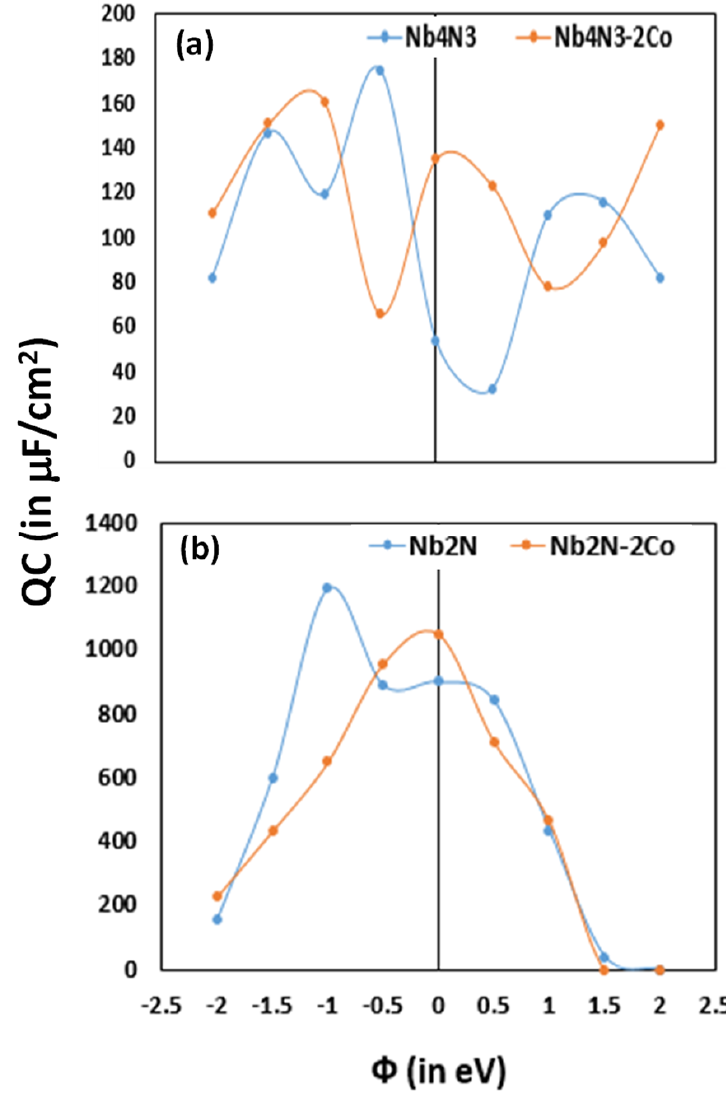
Figure 7. Comparison of calculated QC at different bias voltages for pristine and doped unpolarized structures. ( a ) Nb 4 N 3 and Nb 4 N 3 -2Co; ( b ) Nb 2 N and Nb 2 N-2Co.